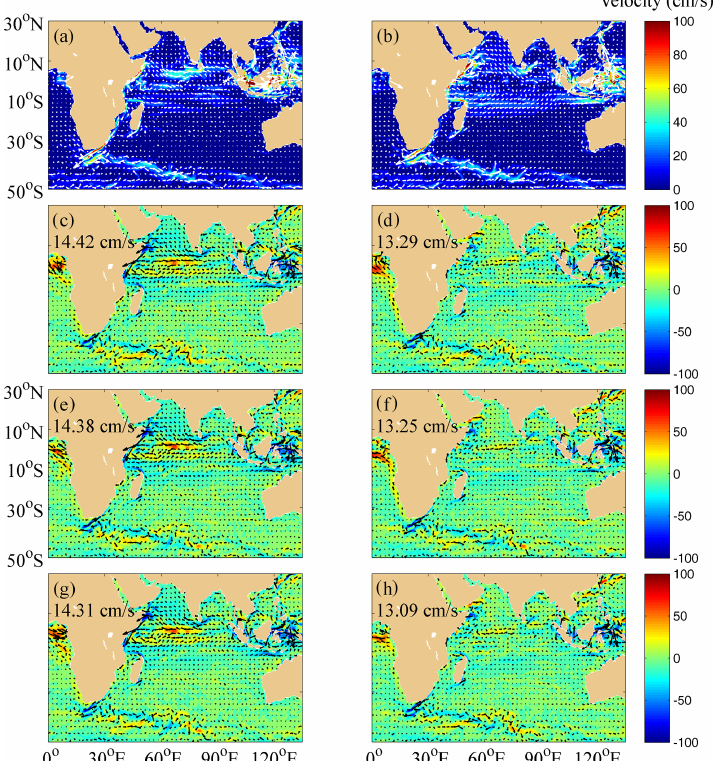
Figure 13. The distribution of surface currents from the OSCAR climatologic data and the differences by subtracting the OSCAR data from the mean results from Exp 1 (c, d) , Exp 2 (e, f) and Exp 3 (g, h) in January (c, e, g) and July (d, f, h) . RMSEs of the surface velocities are shown in the upper left corner of the panels. White arrows in panels (a) and (b) represent the surface current vectors, and black arrows in panels (c) – (h) represent the surface current difference vectors. Deep yellow areas correspond to